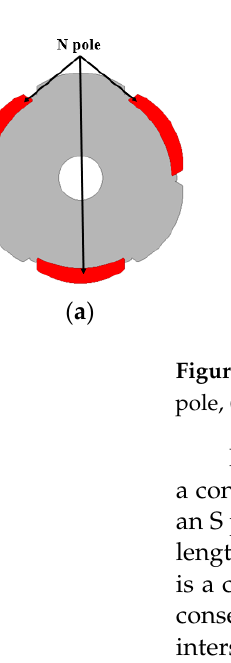
Figure 4. Intersect magnet consequent pole model: ( a ) N pole consequent pole, ( b ) S pole consequent pole, ( c ) intersect magnet consequent pole. Figure 5. Waveforms of back EMF and cogging torque at N pole CP, S pole CP, and intersect magnet CP (2D simulation result): ( a ) noload back emf, ( b ) cogging torque.